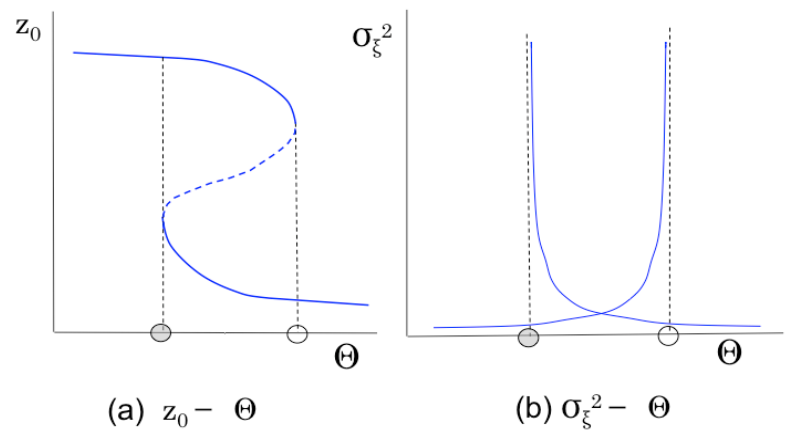
Figure 4. Image of transitions of z 0 and σ ξ2 with respect to the parameter